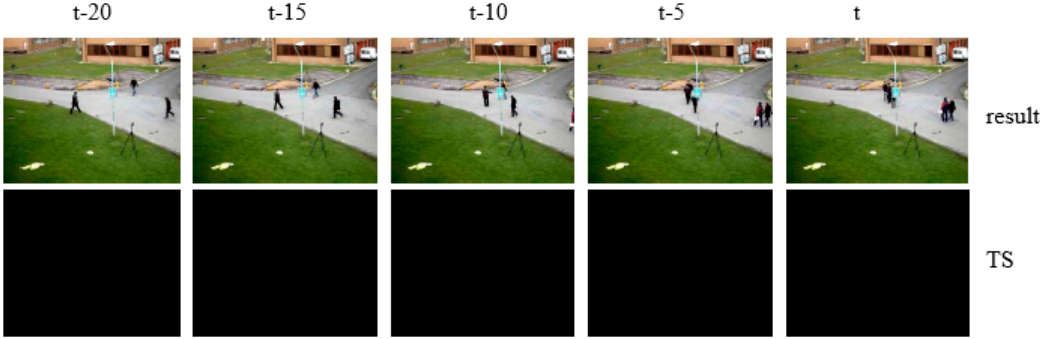
Figure 12. Examples of detection results for abnormality from the No. 5 data.